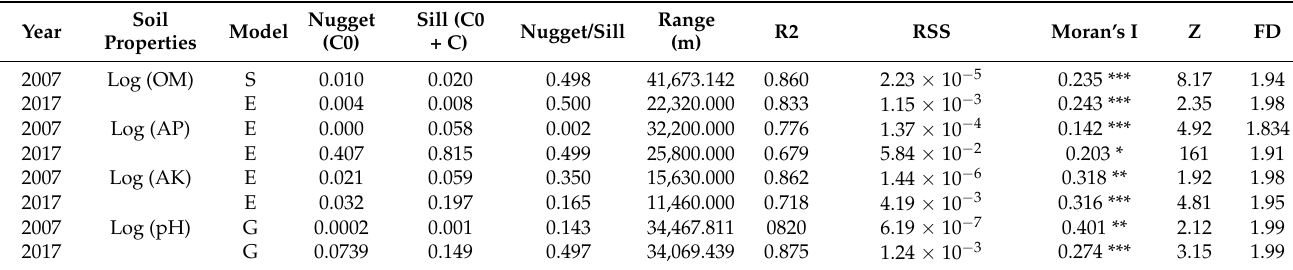
Table 8. Parameters of semivariograms, Moran’s I index, and fractal dimensions (FDs) of soil properties in 2007 and 2017, Hefeng.